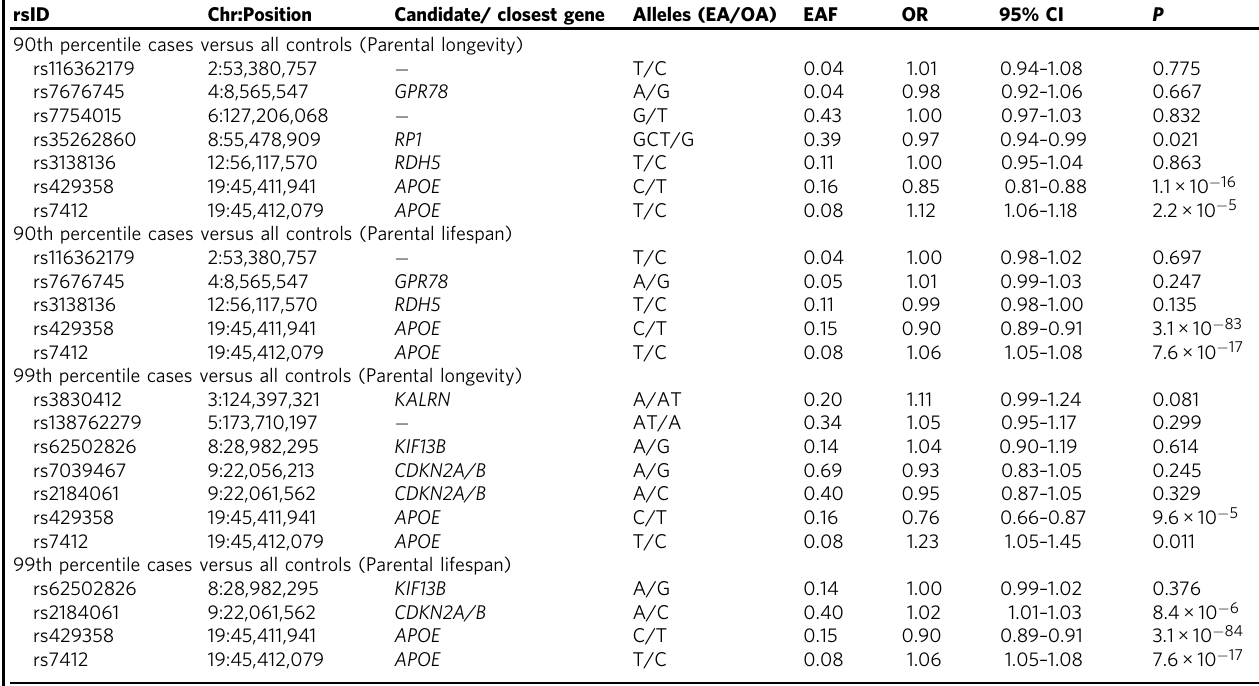
Table 3 Results of the validation in the UK Biobank parental age-based data sets rsID Chr:Position Candidate/ closest gene Alleles (EA/OA) 90th percentile cases versus all controls (Parental longevity)